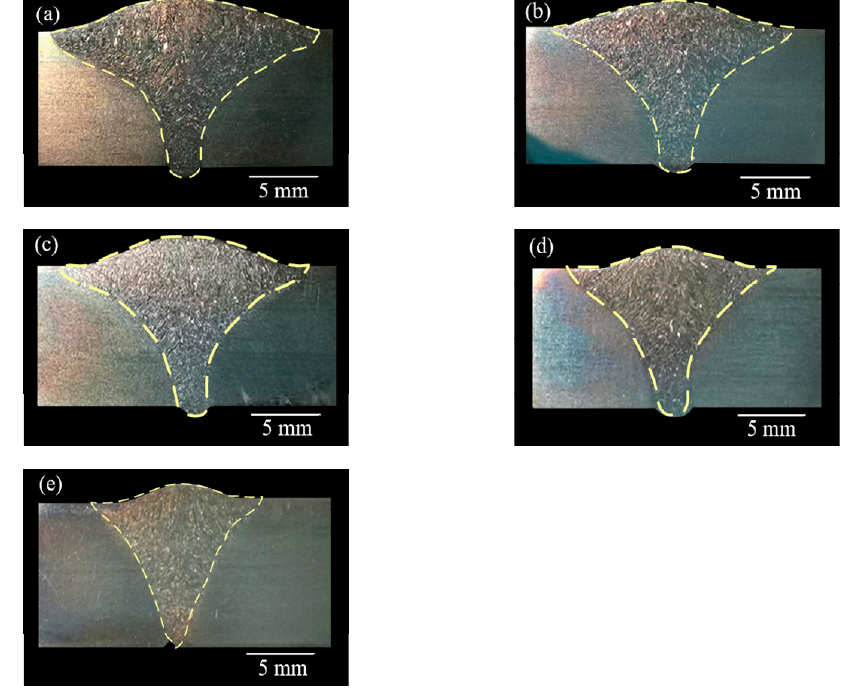
Figure 3. Cross section of 2205 DSS K-TIG welded joints at different weld speeds: ( a ) 280 mm/min, ( b ) 300 mm/min, ( c ) 320 mm/min, ( d ) 340 mm/min, and ( e ) 360 mm/min.